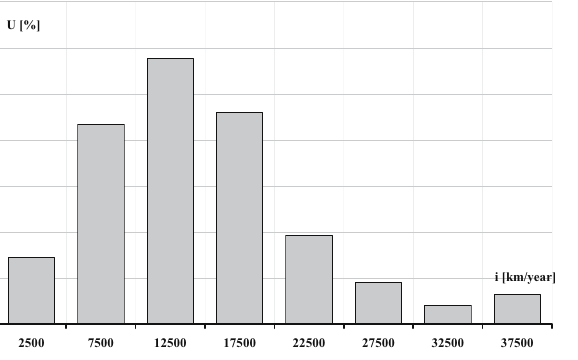
Figure 9: Histogram of vehicle use intensity.